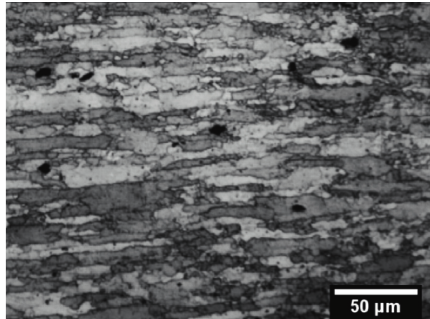
Figure 13: Micrograph of TMAZ in AS of the weld showing Cu- rich dark regions.